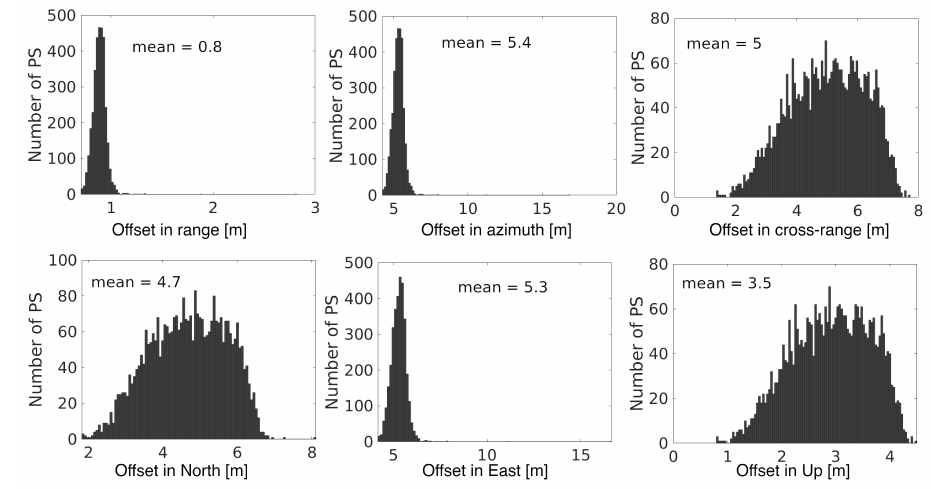
Figure 6. 3-D geolocation offset estimates [m] in radar coordinates with range, azimuth and cross-range directions (top row), and in terrestrial reference coordinates with latitude, longitude and height (bottom row). The ’mean’ is the mean of the offset values.